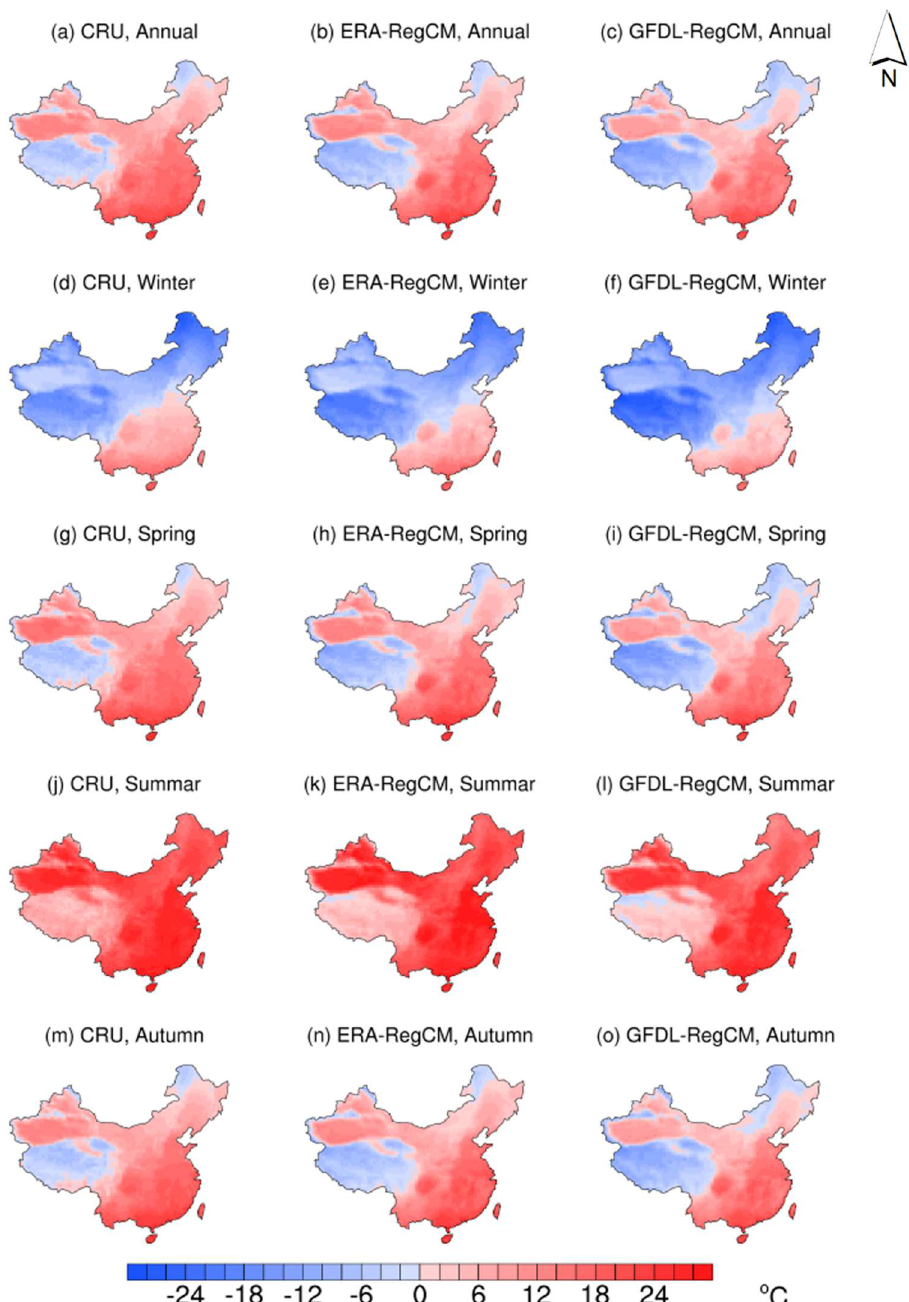
Figure 1. Observed and RegCM-simulated near-surface temperature over China. The annual and seasonal averages are calculated with respect to the baseline period of 1986 to 2005.